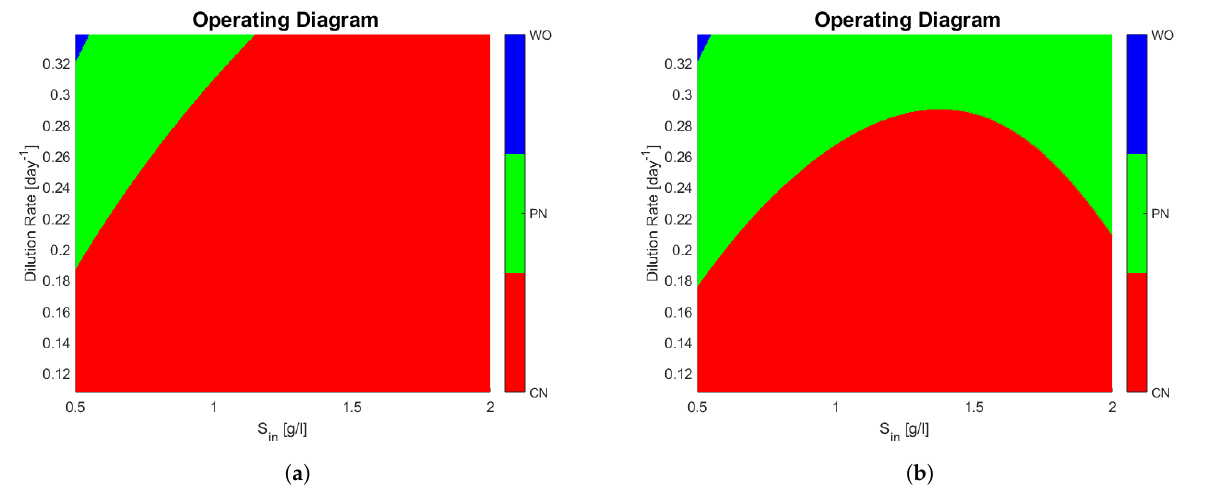
Figure 2. ( a ) Operating diagram of model (3) with no interactions (interaction matrix represented by Figure 1a). ( b ) Operating diagram of model (3) with interactions represented by Figure 1b. Note how ( b ) has a much larger zone where partial nitrification takes place. This is due to the negative interaction of x 1 on x 2 . Table 2. A set of kinetic parameters of model (3).